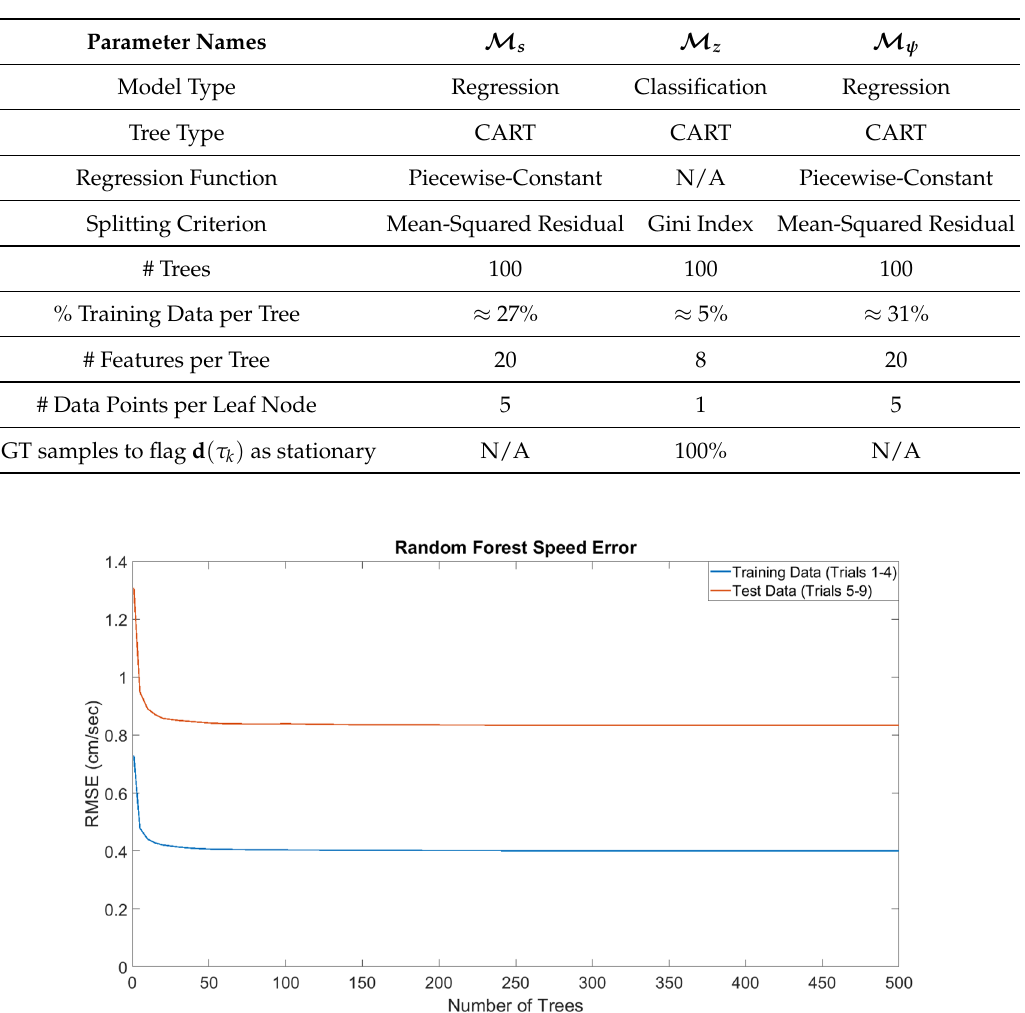
Table 2. Random forest model hyperparameters.